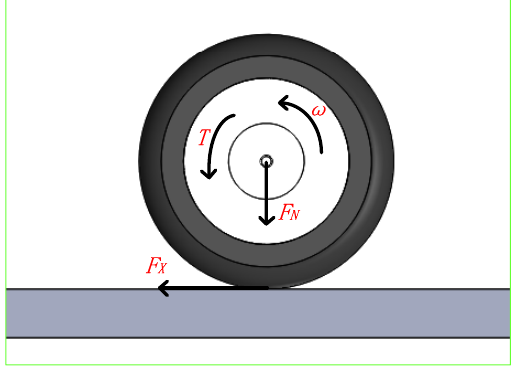
Figure 3. Force analysis of the driving wheel.